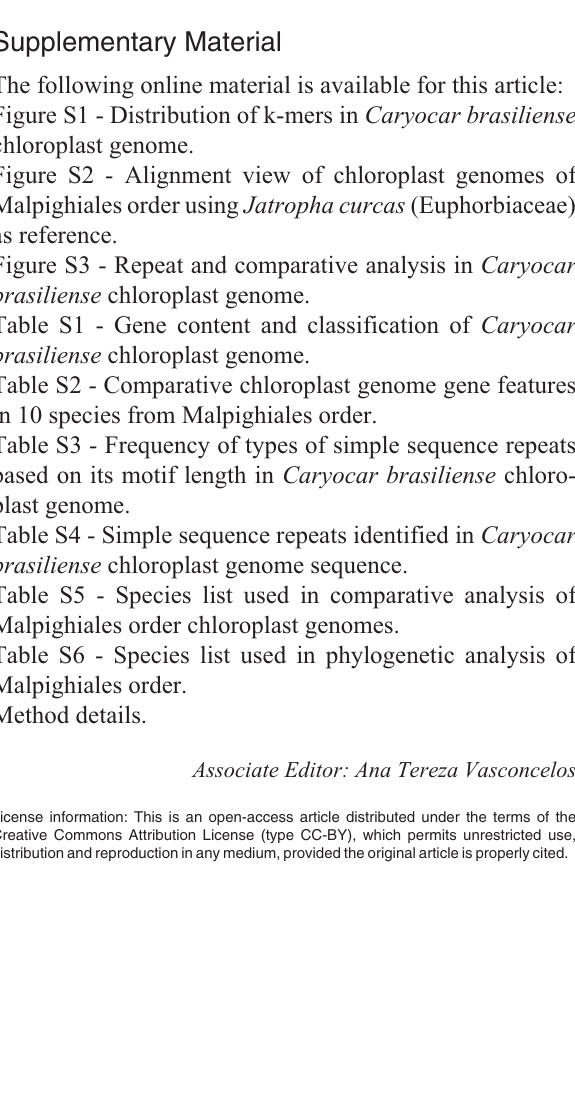
Figure S1 - Distribution of k-mers in Caryocar brasiliense chloroplast genome. Figure S2 - Alignment view of chloroplast genomes of Malpighiales order using Jatropha curcas (Euphorbiaceae) as reference. Figure S3 - Repeat and comparative analysis in Caryocar brasiliense chloroplast genome. Table S1 - Gene content and classification of Caryocar brasiliense chloroplast genome. Table S2 - Comparative chloroplast genome gene features in 10 species from Malpighiales order. Table S3 - Frequency of types of simple sequence repeats plast genome. Table S4 - Simple sequence repeats identified in Caryocar brasiliense chloroplast genome sequence. Table S5 - Species list used in comparative analysis of Malpighiales order chloroplast genomes. Table S6 - Species list used in phylogenetic analysis of Malpighiales